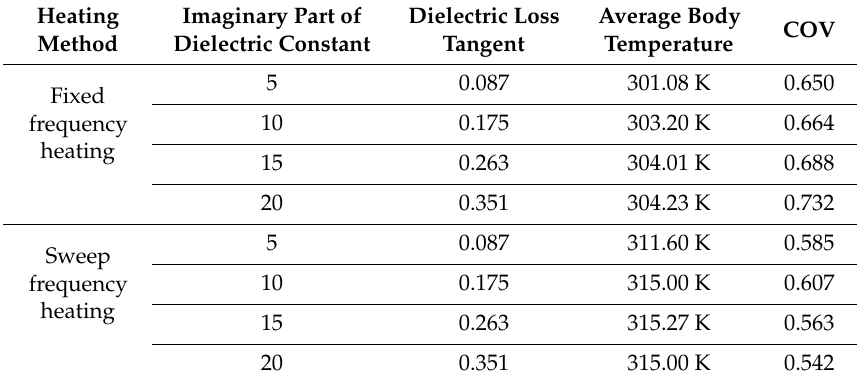
Table 8. Simulated heating results for di ff erent Imaginary part of dielectric